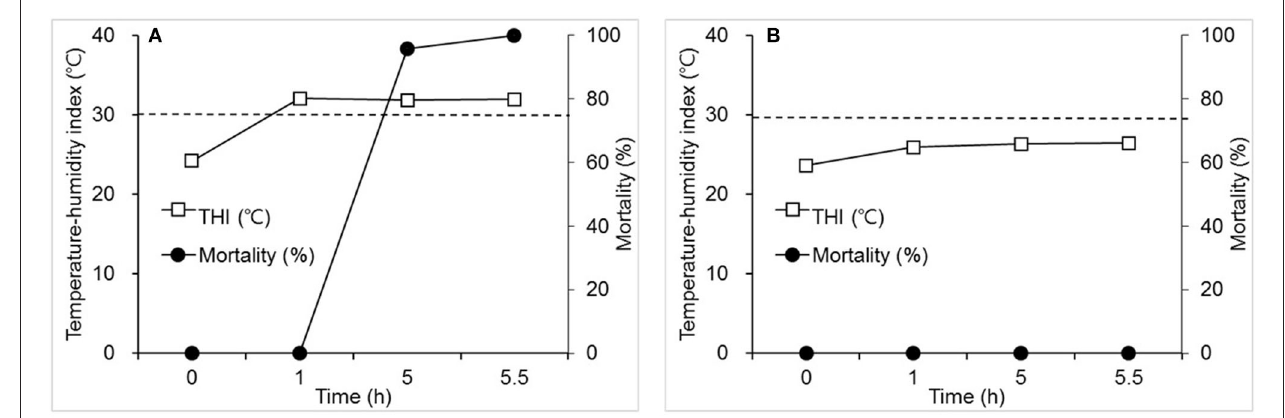
FIGURE 1 | The effects of an acute elevation in temperature-humidity index (THI) ( ◦ C) on mortality (%) in laying hens. Hens were exposed to one of the two following THI conditions for 5.5h. (A) THI: 24.2–32.0; dry-bulb temperature (Tdb) ( ◦ C): 26.8–36.0; web-bulb temperature (Twb) ( ◦ C): 20.3–26.6; and relative humidity (RH) (%): 56.0–45.5. (B) THI: 23.6–26.4; Tdb: 26.0–30.0; Twb: 20.0–21.5; and RH: 58.0–45.0. Mortality was measured at the time points specified (h). The dot line indicates THI of 30 ◦ C. N = 24 for A and 12 for